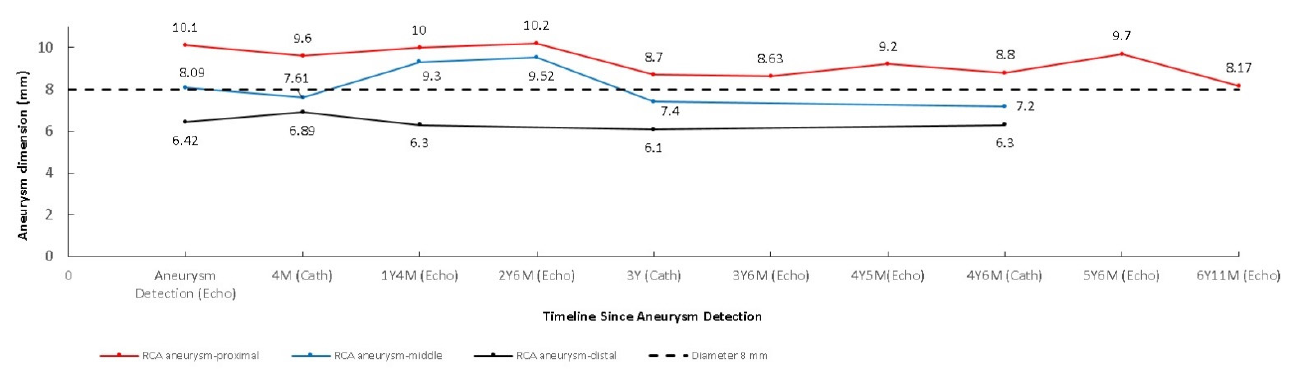
Figure 2. Selective right coronary aneurysm was showed in this figure. Right coronary angiogram showed a beaded pattern of a saccular/fusiform aneurysm.